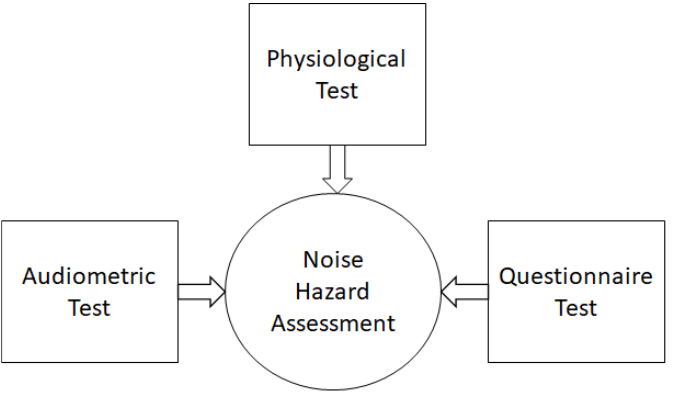
Figure 1. Noise Hazard Assessment Techniques.